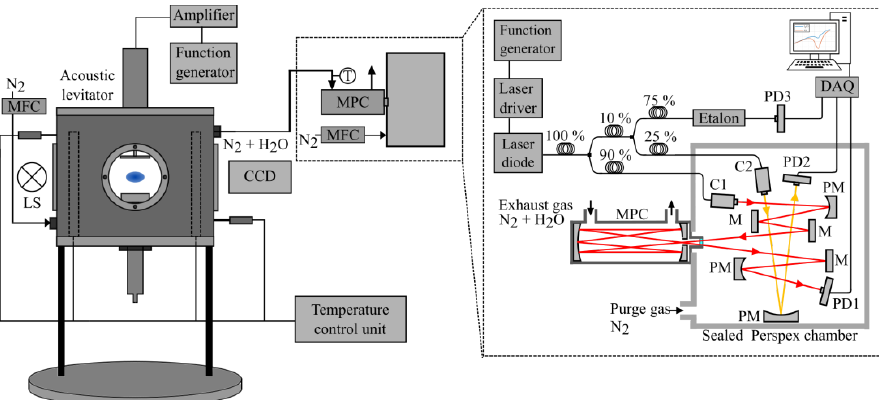
Figure 1. TDLAS hygrometer applied to the acoustic levitator. Optical components: fiber collimator (C1, C2), parabolic mirror (PM), mirror (M), photo diode (PD1, PD2, PD3). The central part of the hygrometer is the single mode fiber-coupled diode laser (NTT Electronics NLK1B5EAAA, Yokohama, Japan) with its emission wavelength centered around the 110 → 211 transition at 1396.97 nm. The distributed feedback (DFB) laser is mounted on a Peltier cooled 14-pin butterfly laser mount (Arroyo Instruments 205 TEC Butterfly LaserMount, San Luis, CA, USA), and is temperature-stabilized and powered by a combined laser driver (Arroyo Instruments 6305 ComboSource, San Luis, CA, USA). In order to tune the laser across the absorption line, a function generator (Fluke Calibration Type 271, Eindhoven, The Netherlands) supplies a triangular current modulation from 30 mA to 80 mA at 26 °C diode temperature with a frequency of 2 Hz. The emitted and fiber- coupled laser light is then split approximately into 90%, 7.5% and 2.5% fractions by a se- ries connection of two 1 × 2 fiber optical splitters (Thorlabs TW1430R2A1 and TW1430R3A1, Newton, NJ, USA). The 7.5% part is coupled into a fiber-Fabry – Pérot inter- ferometer (Etalon; Micron Optics FFP-I, Roanoke, VA, USA) and the transmitted light is detected by an amplified InGaAs-detector (PD3; Thorlabs PDA10CF-EC, Newton, NJ, USA) to determine the dynamic tuning coefficient 𝑑𝜈 of the laser. The remaining two frac- 𝑑𝑡 tions of 90% and 2.5% are guided into a sealed Perspex chamber, where they are trans- ferred into the free space by two fiber collimators (C1, C2; Thorlabs CFC5-C (C1) and F260APC-C (C2), Newton, NJ, USA). The Perspex chamber is continuously purged with nitrogen (Linde Nitrogen 5.0, Pullach, Germany), but it is almost impossible to keep it is used as a reference signal 𝐼 𝑟𝑒𝑓 (𝜈,𝑡) to monitor the remaining amount of water vapor in the free space region inside the Perspex chamber, allowing for a correction of the meas- ured water mole fractions in the MPC by the corresponding amount. After an absorption GaAs-detector (PD2; Thorlabs PDA10CF-EC, Newton, NJ, USA). The 90% fraction, illus- trated as red line in Figure 1, is used to determine the amount of water in the exhaust gas